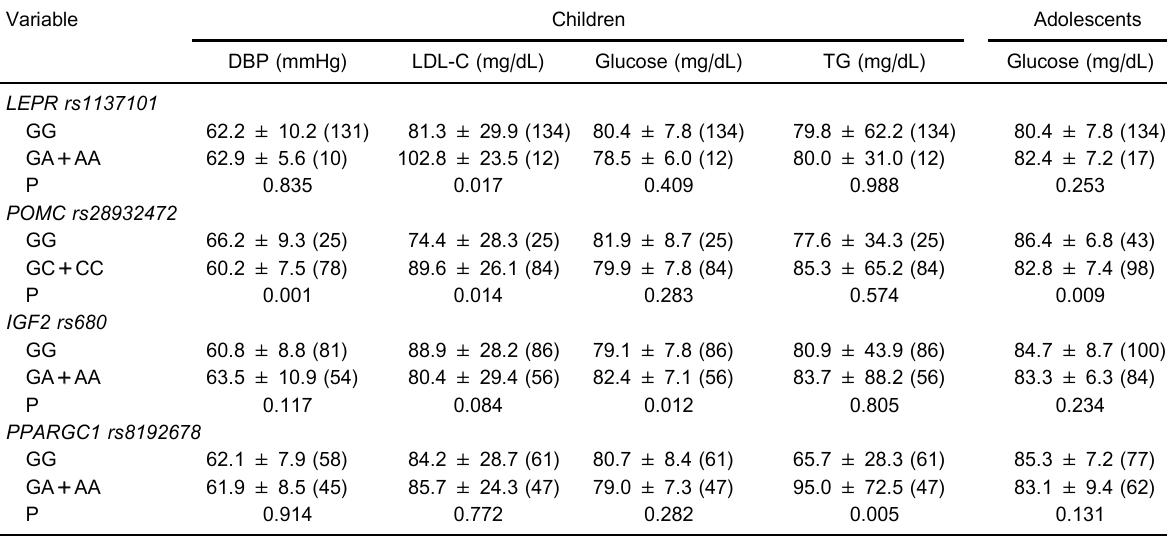
Table 3. Summary of anthropometric, clinical, and biochemical characteristics of children or adolescents according to genotype groups in the dominant model.